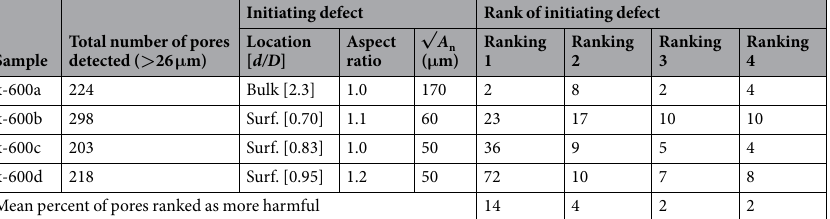
Table 1. Details about the pore distributions and the initiating defect in each sample estimated using different ranking strategies.